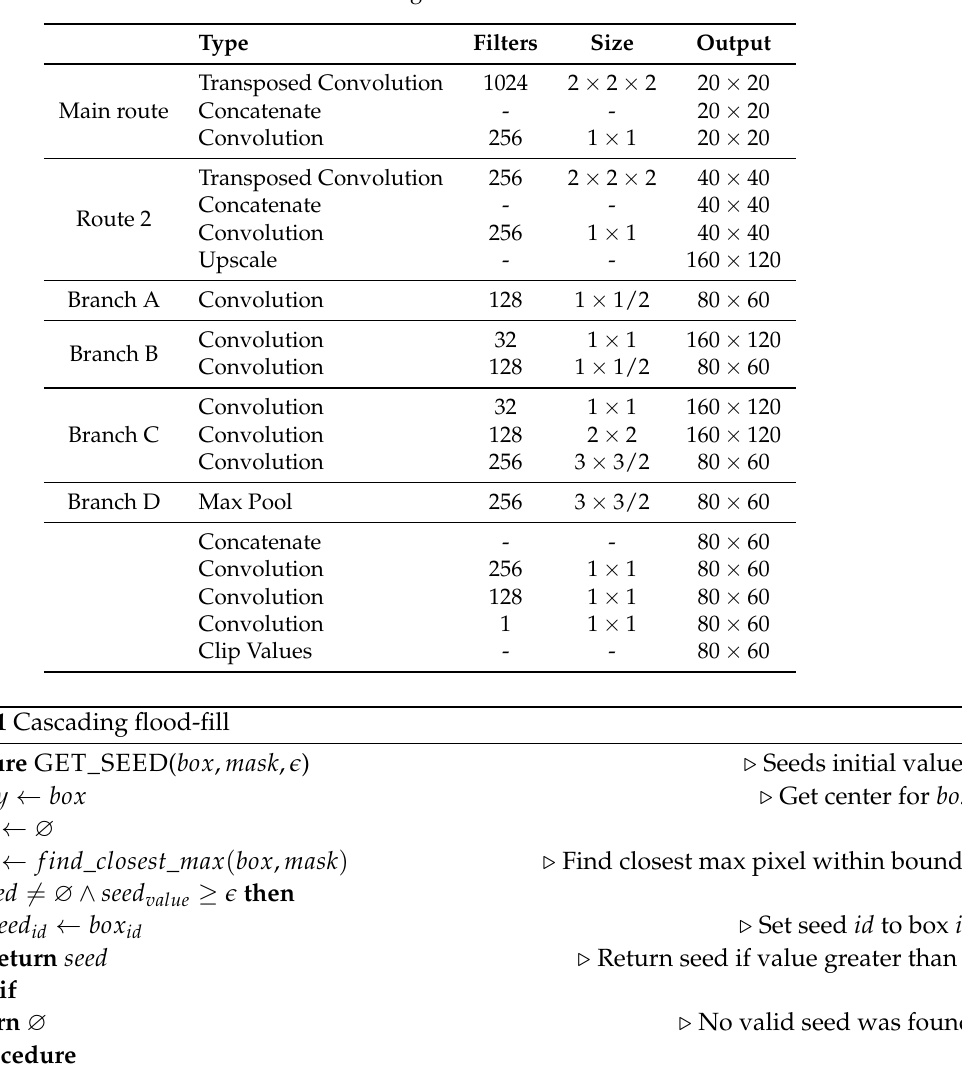
Table 1. Geometric Segmentation architecture.